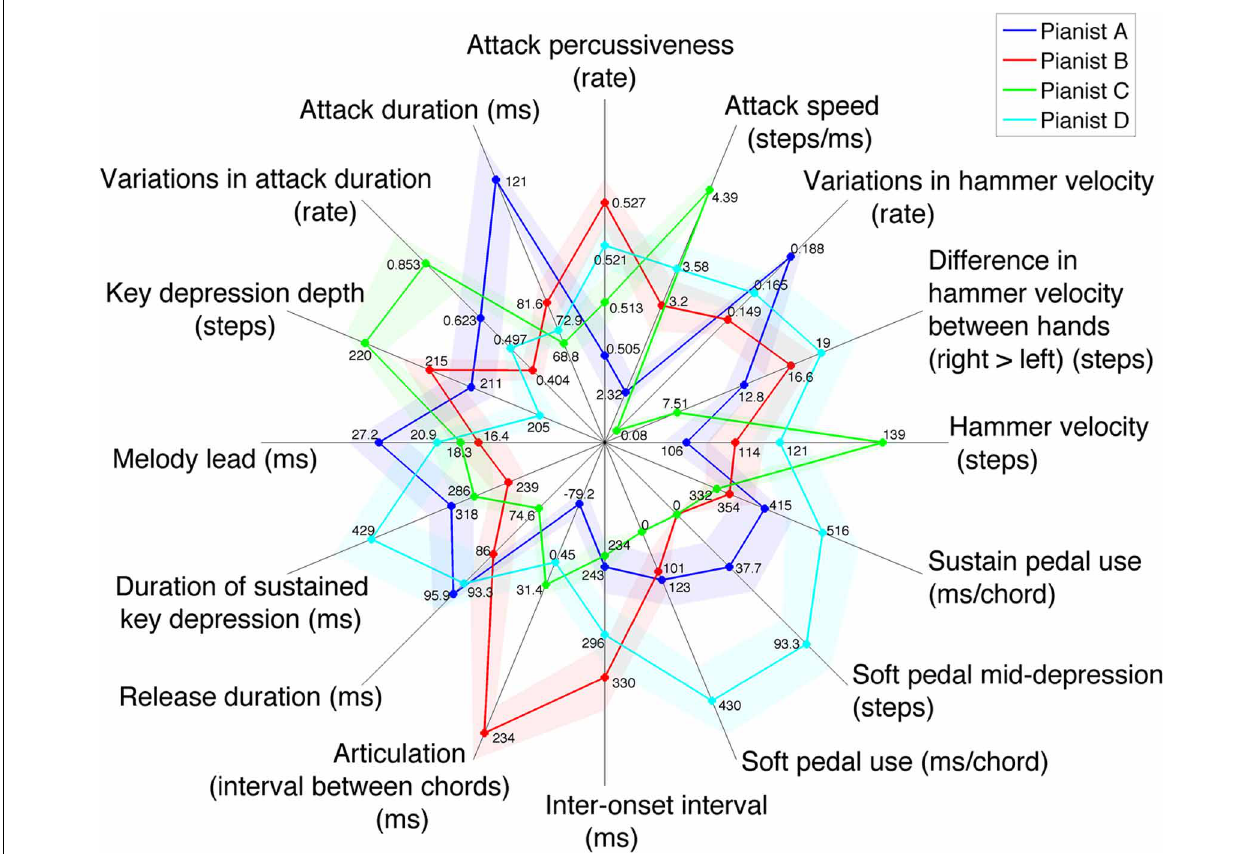
FIGURE 3 | Kiviat chart of the 16 performance features giving a minimal and unique description of four pianists’ individual performance patterns. Z-scores per pianist are plotted for each feature with colored dots, with the